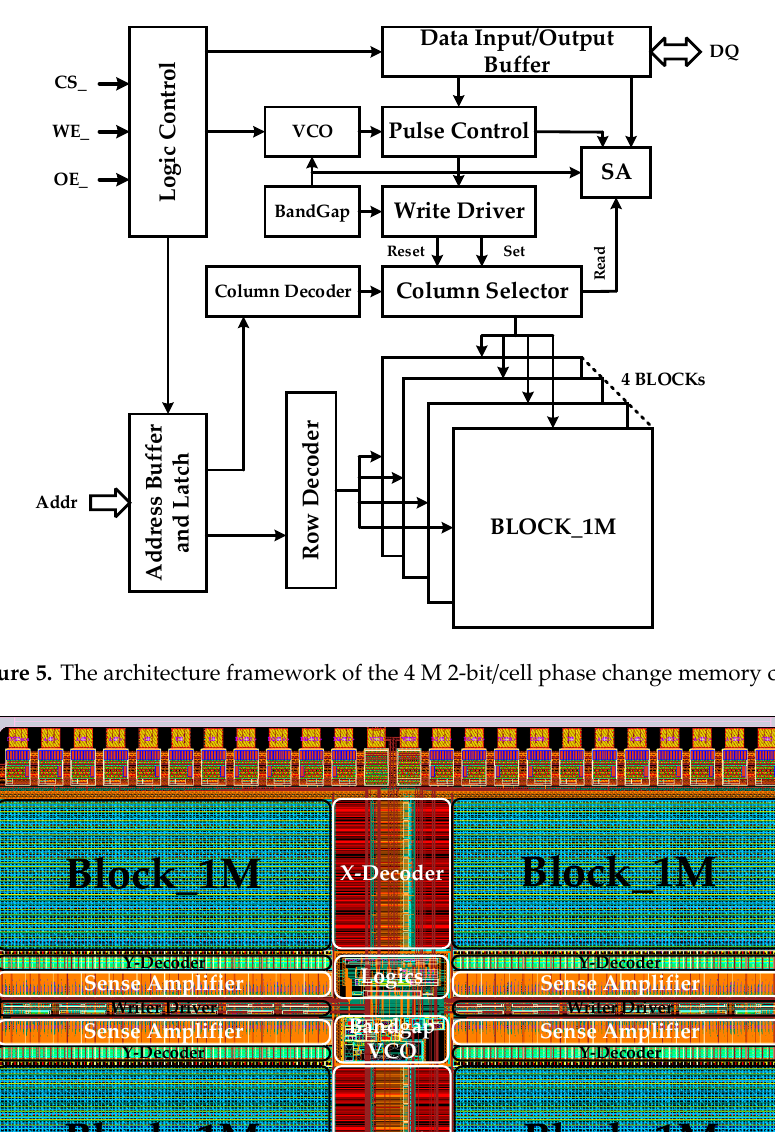
(j) Figure 7. Programmable ramp-down current pulse for SET operation: ( a ) is a rectangular SET pulse without a ramp-down edge; ( b – f ) are ramp-down pulses with 1/2/3/4/5 steps, respectively; ( g ) is a five-step ramp-down pulse with a larger initial amplitude; ( h ) is a five-step ramp-down pulse with a larger initial width; ( i , j ) are five-step ramp-down pulses with different widths. To achieve the above scheme, the ramp-down current pulse generator circuit designed in this paper is shown in Figure 8a. The generator consists of eight current mirrors. During the SET programming process, the control switches S<0>~S<7> are turned on or off sequentially according to a certain order, and the SET current pulse with a specific shape can then be generated. The slope of the descent edge can be changed by controlling the opening time of each current source. In addition, in order to facilitate adjustment, a number of switches are designed in each current source, as shown in the lower half of Figure 8a. Four different amplitudes can be obtained by adjusting the combination of signal S0H <1:0>, and the height of each pulse in the ramp-down current can then be adjusted. Considering the high voltage on the bit line during the write operation, the transmission gate is